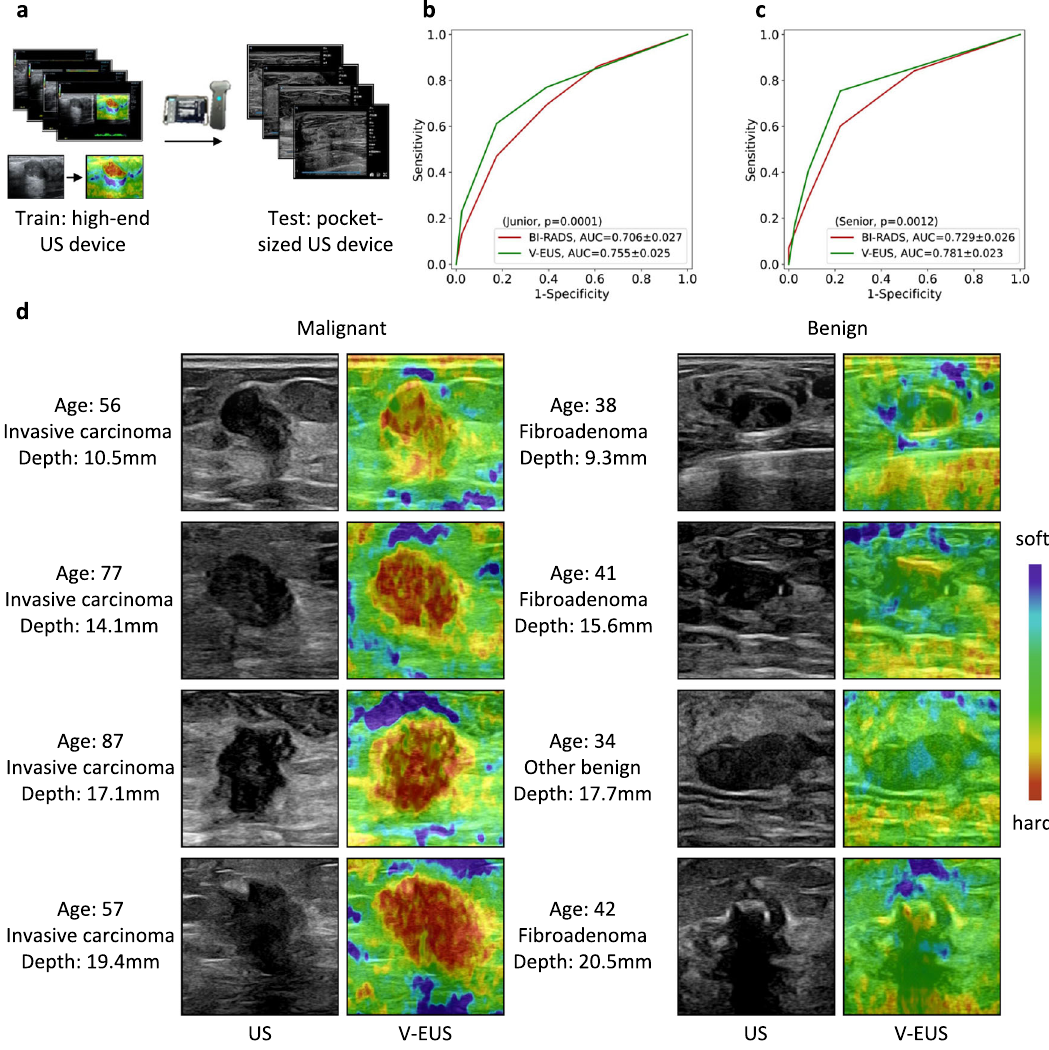
Fig. 5 | Adaptability to pocket-sized US images. a The deep learning model trainedonhigh-qualityUS images is adapted to low-quality pocket-size US images. b ROCs comparison of blind evaluation results of the junior radiologist. c ROCs comparison of blind evaluation results of the senior radiologist in diagnosing